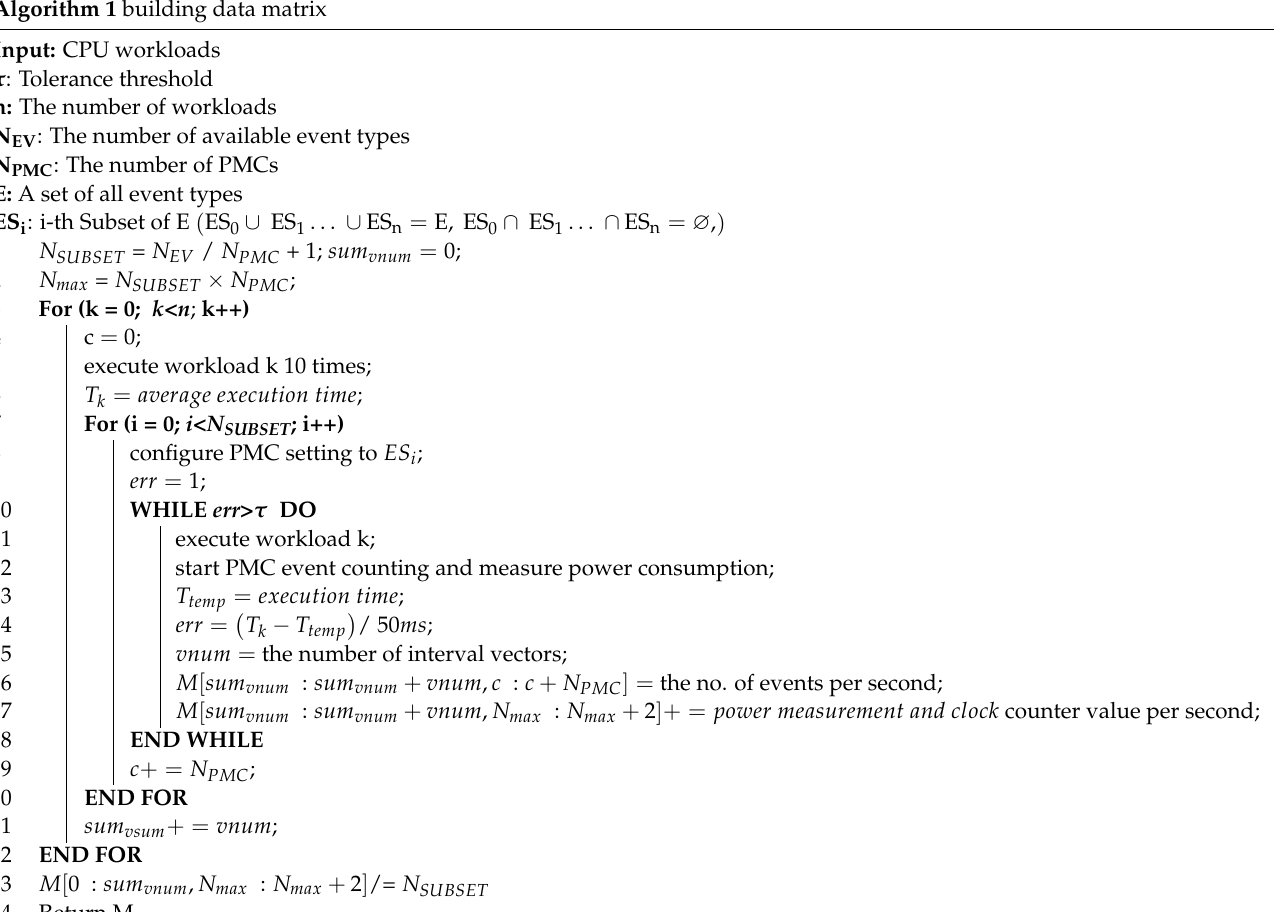
Algorithm 1 building data